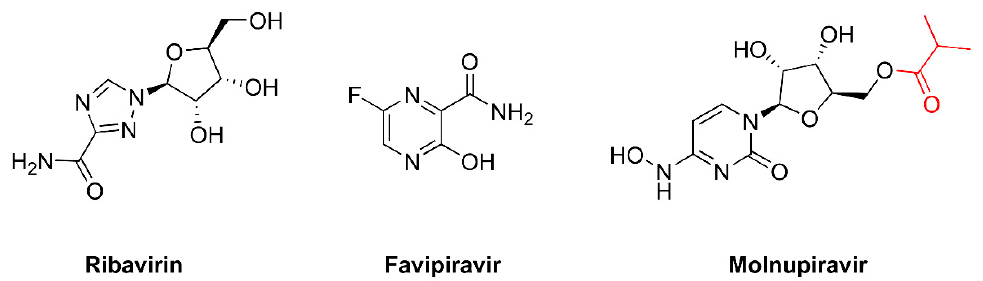
Figure 2. Chemical structures of approved drugs inducing mutagenesis in viral replication assays. Molnupiravir is the isopropylester prodrug of β - D -N 4 -hydroxycytidine. The isopropylester moiety is shown in red.